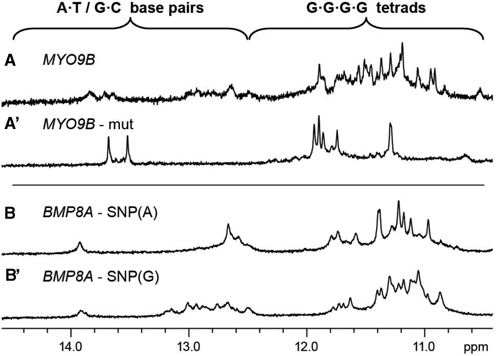
Modifications to nucleotide sequences affect the structural conformations adopted by SLQS. Shown here are the 1D imino proton NMR spectra of (A) G4ST19017166594 and (A’) its mutated counterpart G4ST19017166594del from the MYO9B gene, as well as two single-nucleotide polymorphs (B) G4ST01039729840A and (B’) G4ST01039729840G from the BMP8A gene.